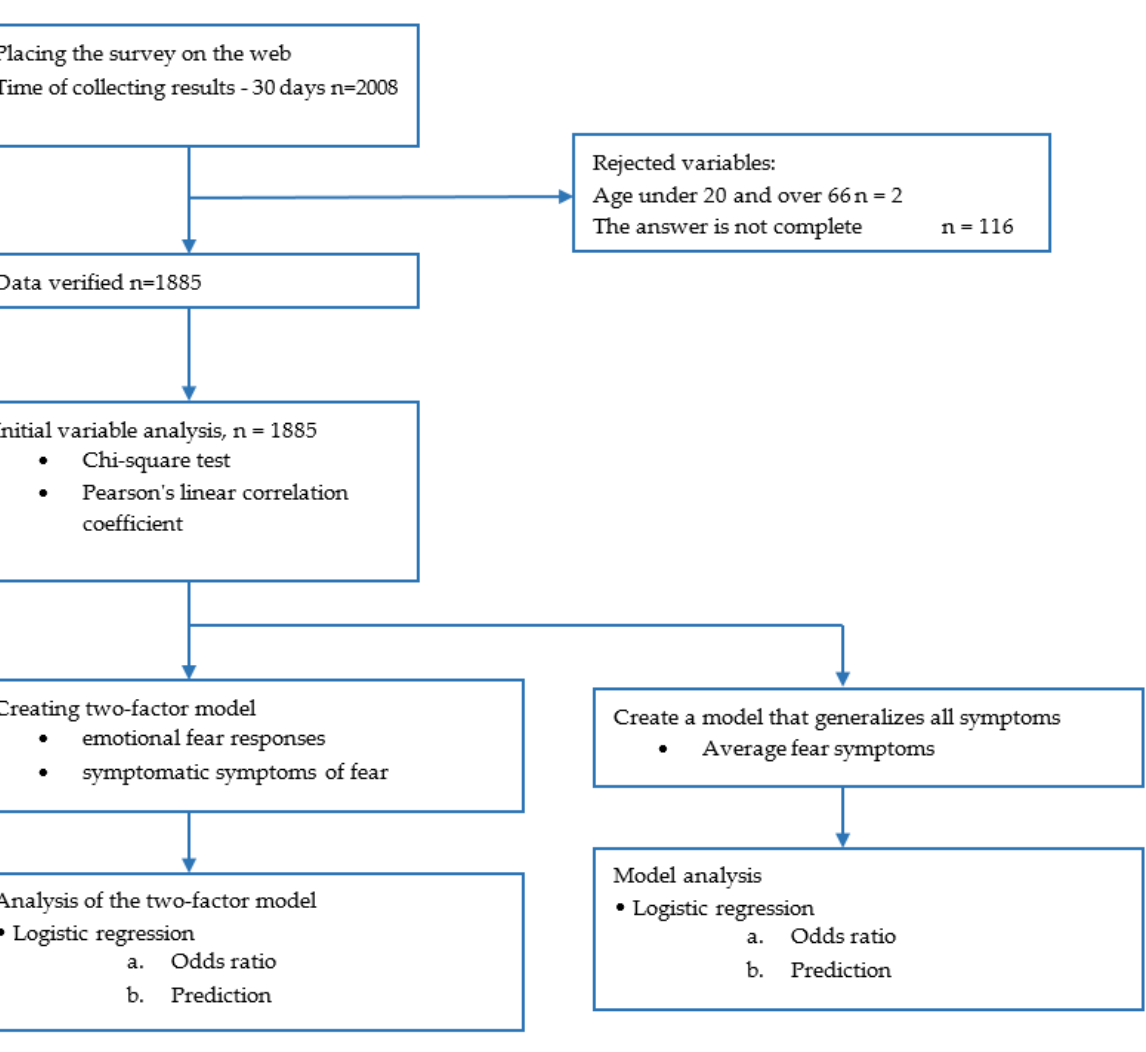
Figure 2. Flow diagram. Source: own study.